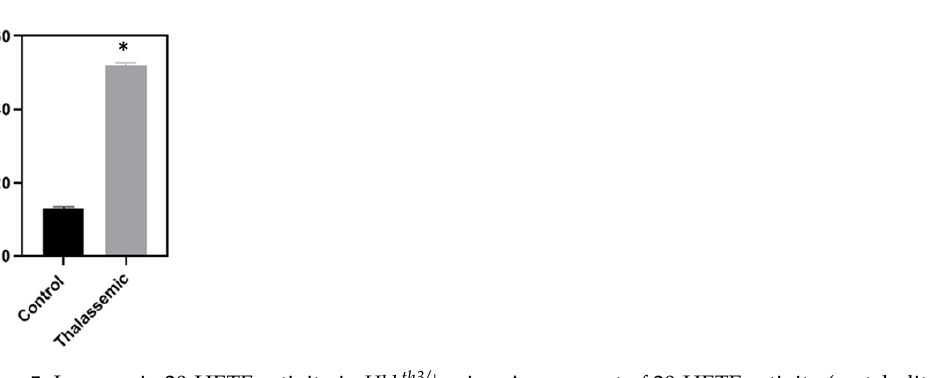
Figure 5. Increase in 20-HETE activity in Hbb th3/+ mice. Assessment of 20-HETE activity (metabolite produced by CYP4A and CYP4F) by HPLC. Values are the means ± SEM from 4 different mice in each group ( n = 4). * p < 0.05 versus control.